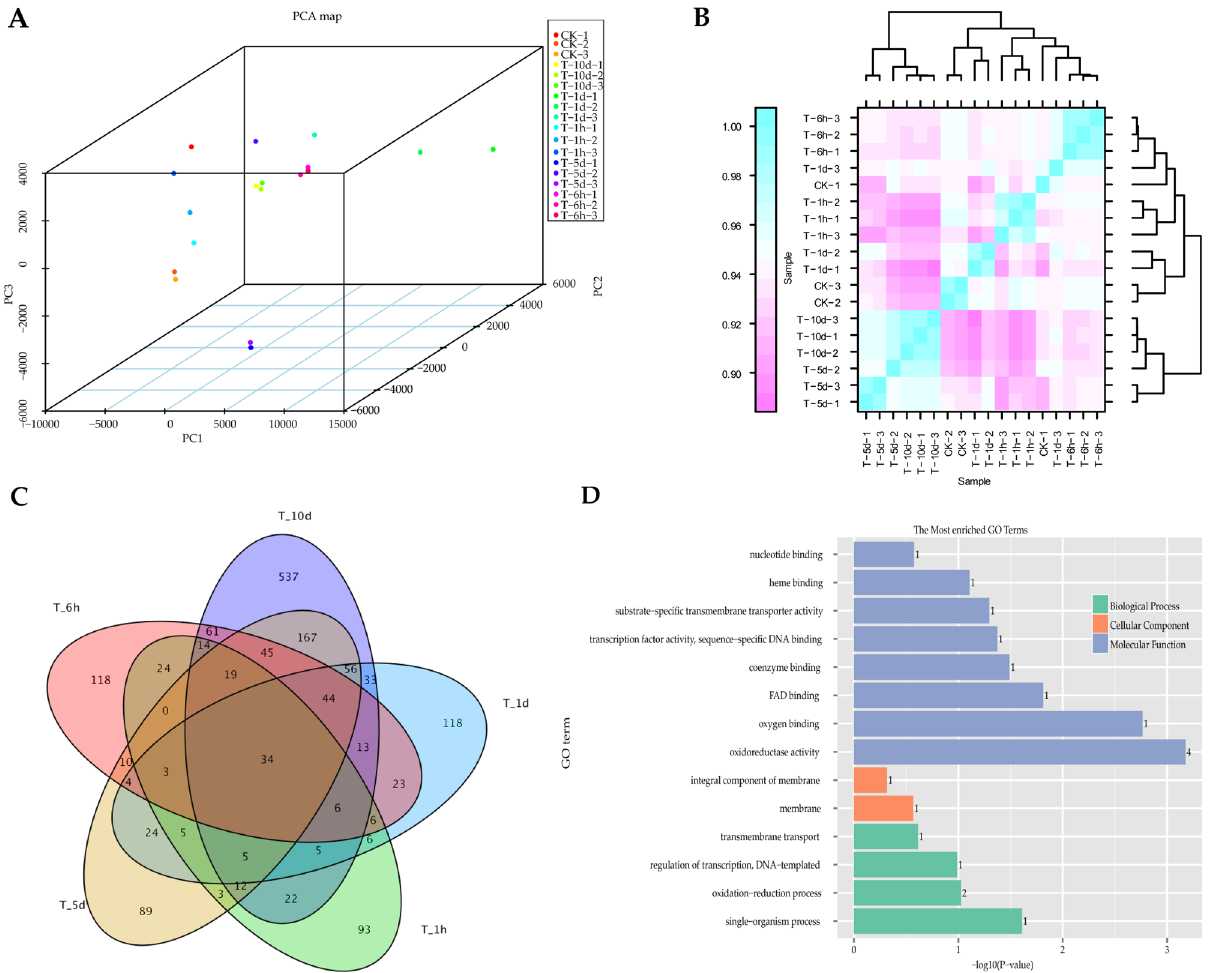
Figure 1. The differentially expressed genes (DEGs) in PSI. ( A ) PCA plot. ( B ) Correlation heat map performed using BMKCloud (http:// www. biocl oud. net). ( C ) The venn diagram for the DEGs shared between the five time points.